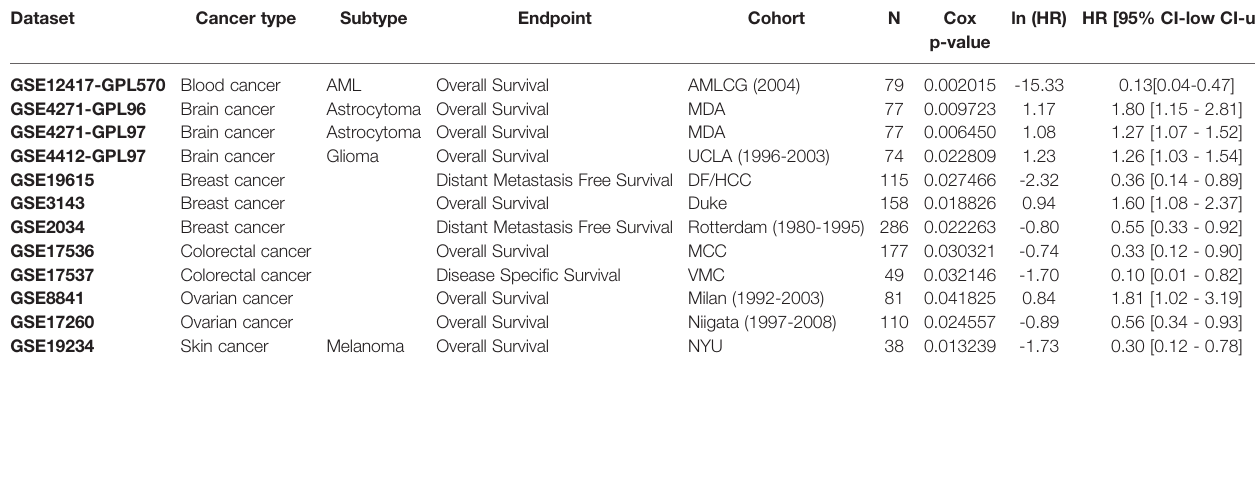
TABLE 2 | Prognostic value of SOCS3 in various cancers in PrognoScan